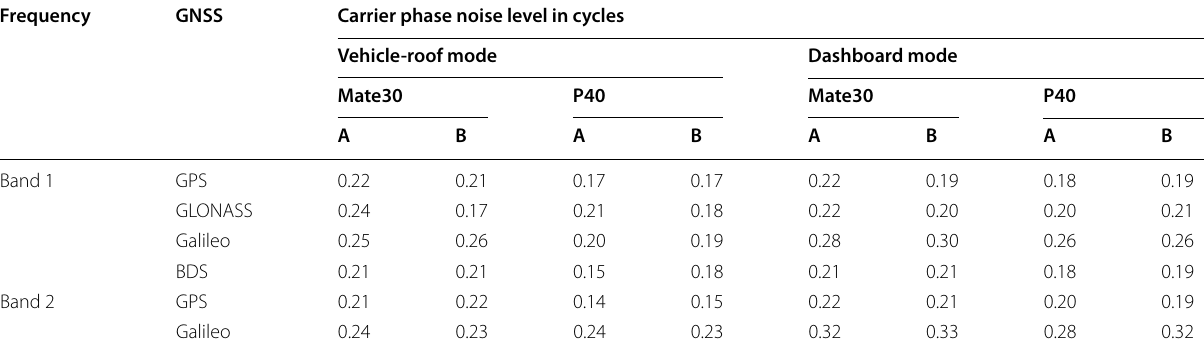
Table 3 Statistic results on the noise levels of GPS, GLONASS, Galileo, and BDS dual-frequency carrier phase measurements of the experimental smartphones in the vehicle-roof mode and dashboard mode by using the triple difference method